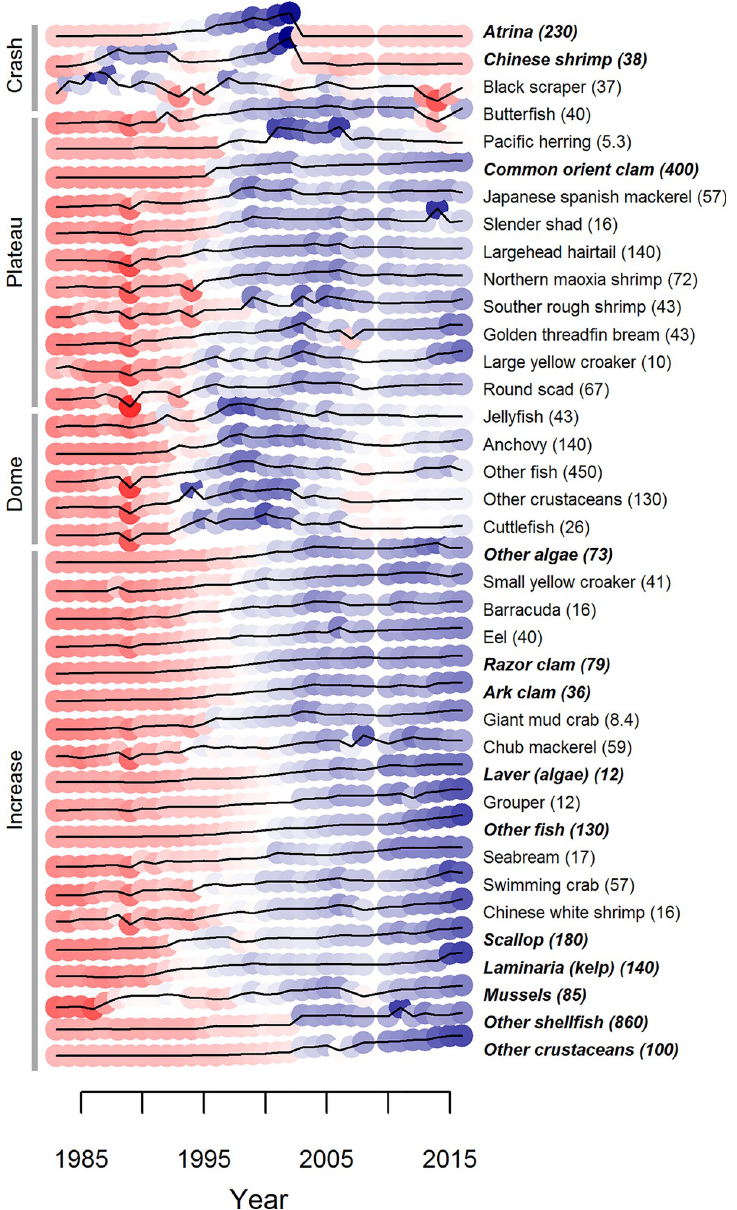
Fig 3. National totals for marine seafood production by species/groups from 1983–2016. Time series are grouped via hierarchical clustering so that time series with similar ‘shapes’ are together. Colors represent the value of a species in a given year relative to the arithmetic mean for that species/group. Red values are below the mean; blue values are above. Names printed in bold italics are aquaculture production and the number in parentheses is the maximum value for that species/group in 10,000